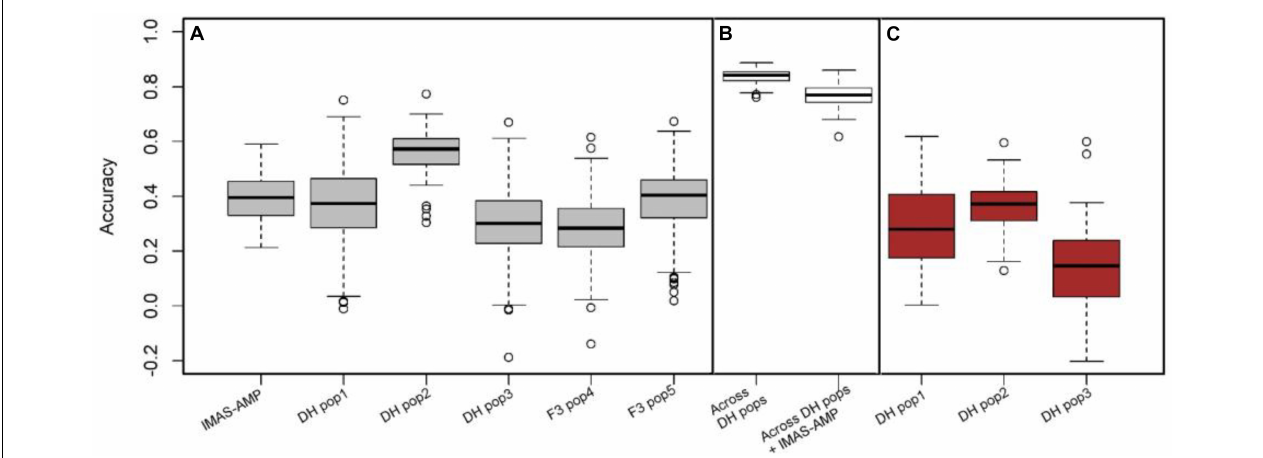
FIGURE 4 | Genome-wide prediction accuracies for GLS resistance in biparental and IMAS AM panel based on three different scenarios. (A) Estimation and prediction within IMAS AM panel and biparental populations; (B) estimation and prediction combined DH populations and combined all DH populations and IMAS AM panel; (C) prediction of the DH population using IMAS AM panel as a training set with fivefold